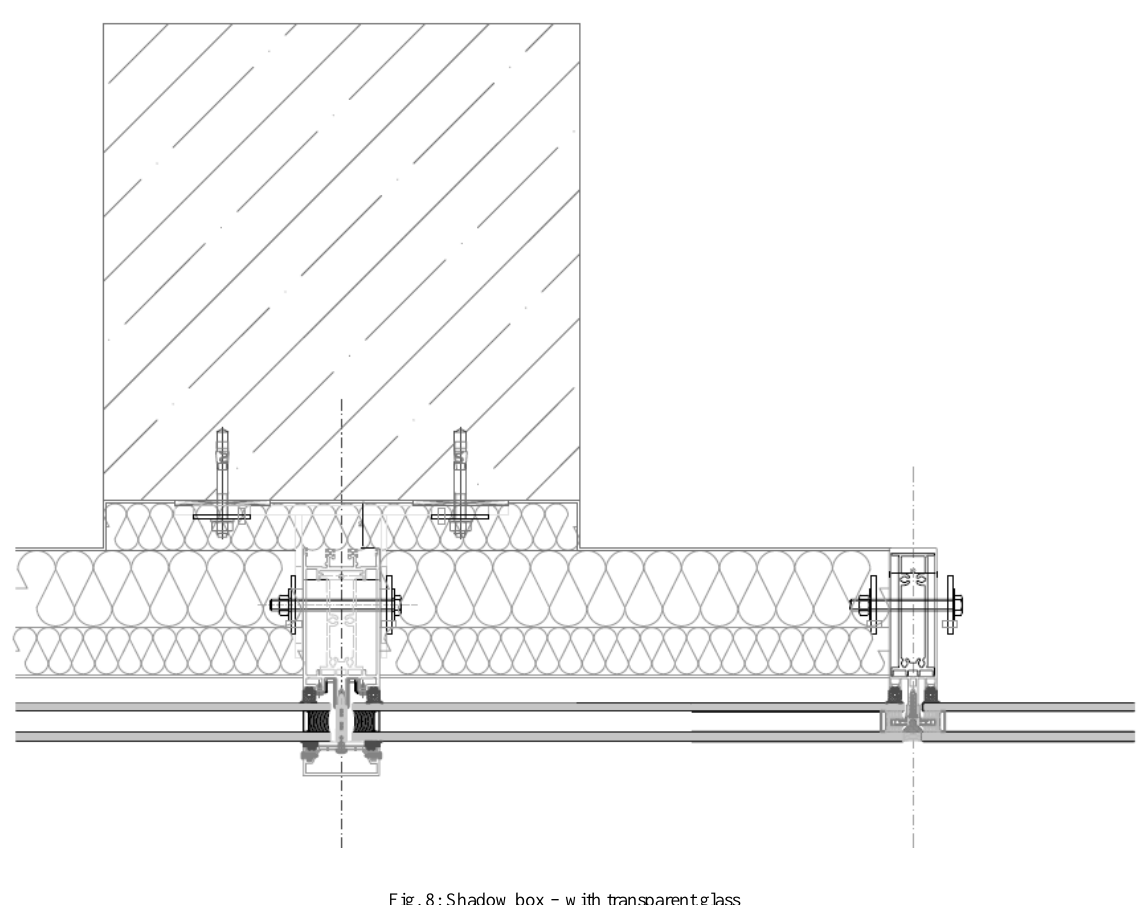
Fig. 8: Shadow box – with transparent